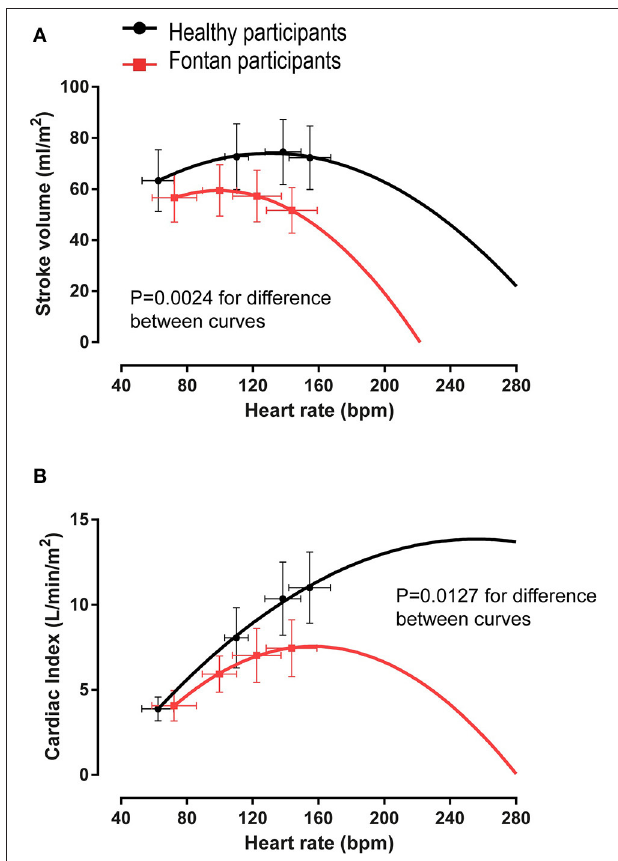
FIGURE 3 | Quadratic regression analysis of mean stroke volume and cardiac output vs. average heart rate values. In people with a Fontan circulation, an additional increase in heart rate beyond peak exercise values would result in (A) a disproportionate fall in stroke volume such that (B) cardiac output cannot increase further. Modified from